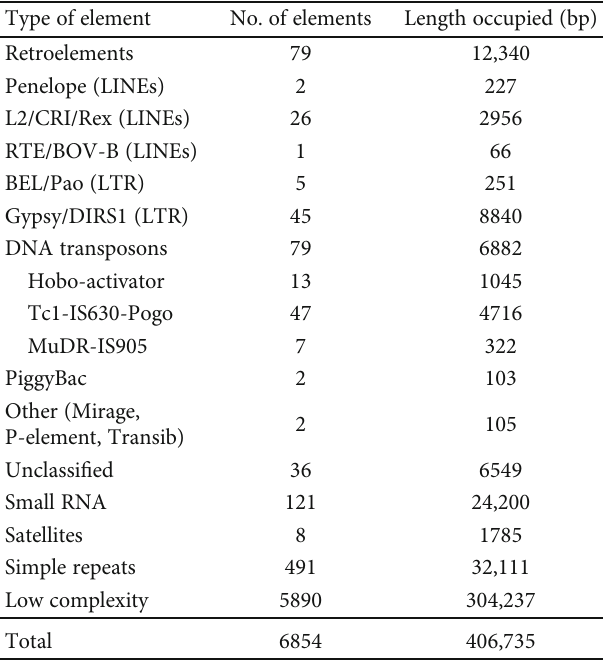
Table 3: Summary of repeats within the reniform nematode genome using the SIGMA genomic library.